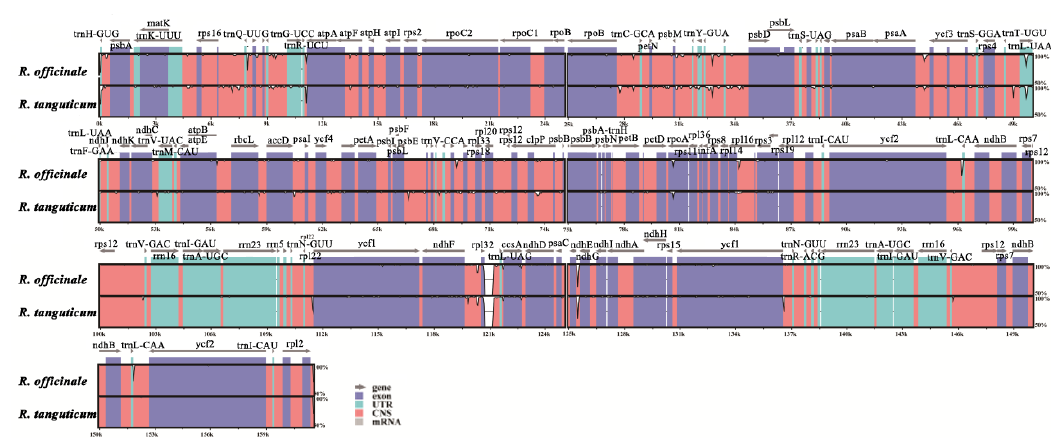
Figure 4. Comparison of three chloroplast genomes using R. palmatum as the reference. The vertical scale indicates the percentage of identity, ranging from 50% to 100%; the horizontal axis indicates the coordinates within the chloroplast genome. Annotated genes are displayed along the top. Genome regions are color-coded as either protein-coding exons, rRNA, tRNA, or conserved non-coding sequences (CNS). UTR: Untranslated Region.